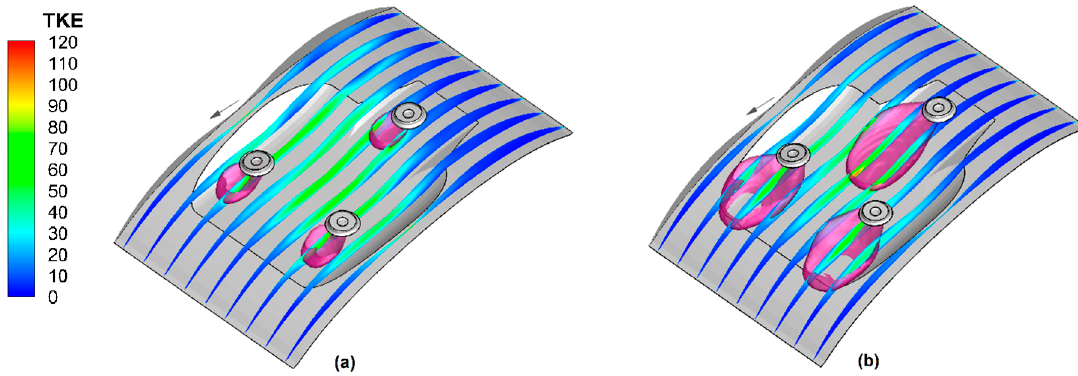
Figure 15. Distribution of TKE (m 2 /s 2 ) and representation of temperature iso-surface of 1500 K for L-slot (far L-T-plug) at ( a ) 10°EA before TDC (10°EA after ST), ( b ) TDC (20°EA after ST).